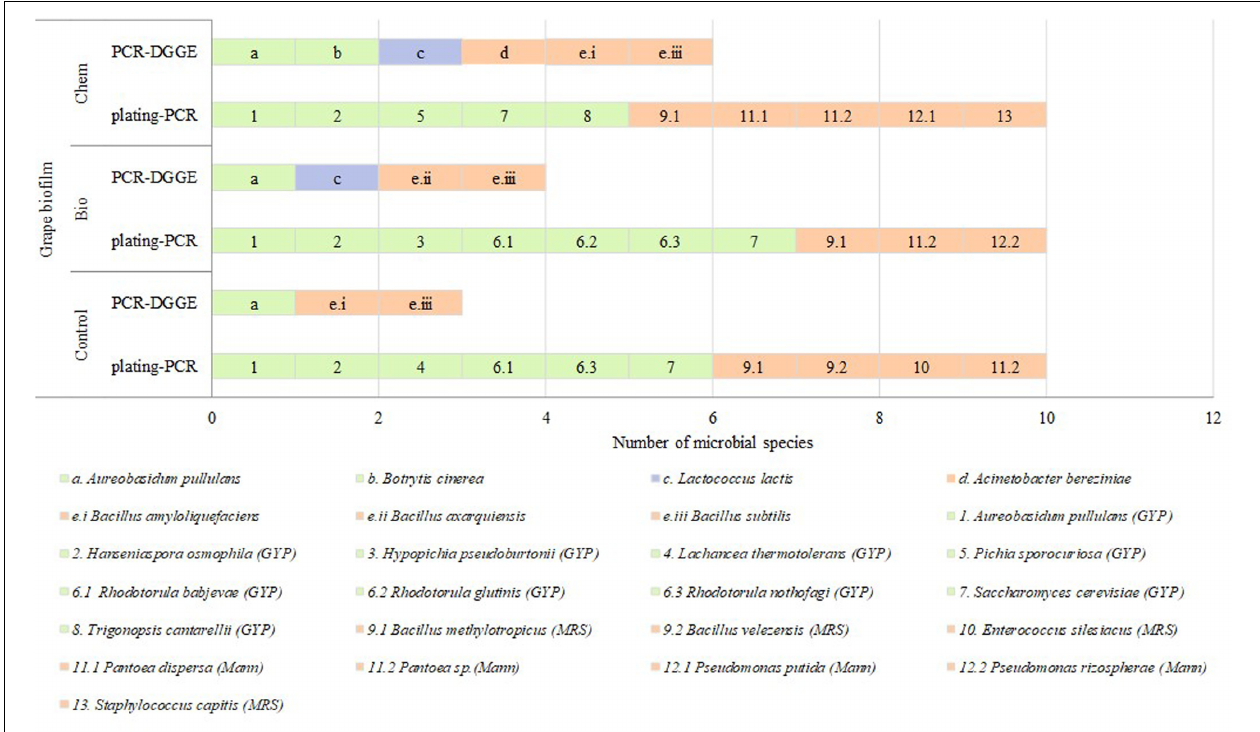
FIGURE 2 | Microbial species detected on grape biofilm samples (C: control, Bio: bio-fungicide, and Chem: chemical fungicide) from GYP, MRS, and Mann plates referred to as letters and by PCR-DGGE referred to as numbers. Green slices identified eukaryotic species; purple slices were LAB; and orange slices EB.